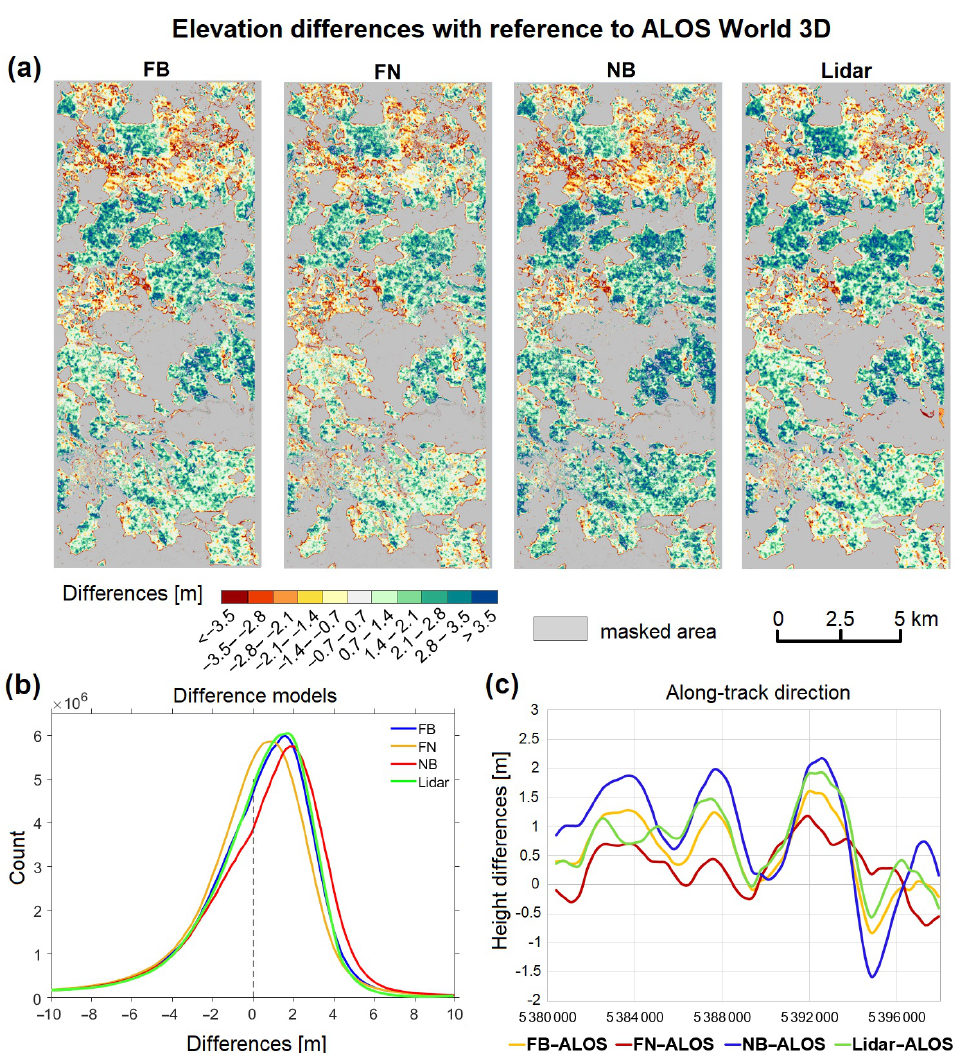
Figure 19. Elevation differences (Pléiades DEMs and Lidar DTM) with respect to ALOS World 3D reference: ( a ) Color coded height difference models (masked areas are shown in grey). ( b ) Frequency distribution of height discrepancies for all combinations. ( c ) Section profile in the along-track direction with Z elevation differences of pairwise DSMs against the reference ALOS World